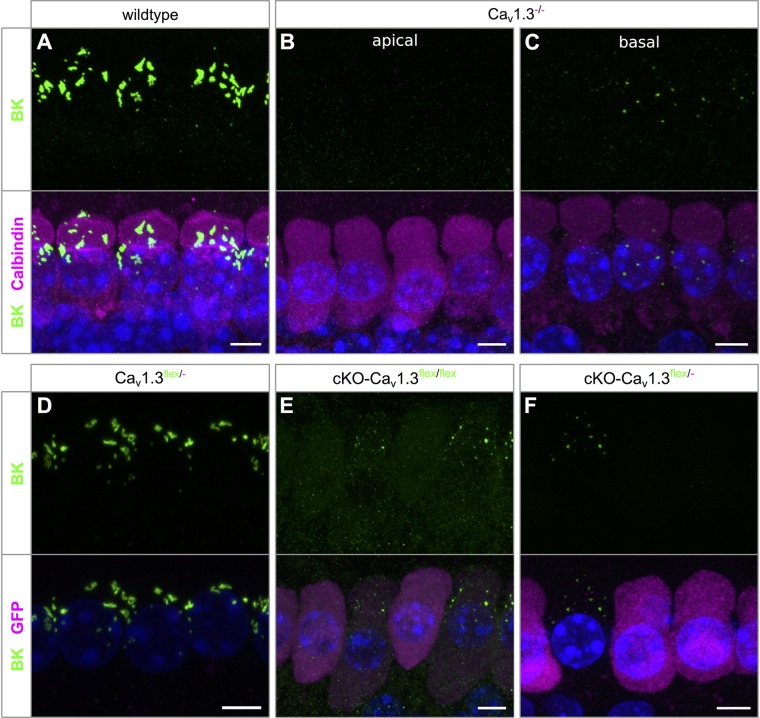
BK channel expression is related to reduced GFP labeling in cKO-Cav1.3flex/flex and cKO-Cav1.3flex/- IHCs. (A–C) MIP of confocal stacks of IHCs labeled for BK (green) and calbindin (magenta) of a wildtype (A) and a Cav1.3-/- mouse (B,C) at the age of 4–5 weeks. (A) Large spots of BK immunoreactivity at the neck of wildtype IHCs. (B,C) In Cav1.3-/- IHCs, BK immunolabeling was absent from apical-turn IHCs (B) and vastly reduced in IHCs of the basal turn (C) compared with apical-turn wildtype IHCs (A). (D–F) Co-labeling for BK channels (green) and GFP (magenta) in apical-turn IHCs of a control Cav1.3flex/-
(D), a cKO-Cav1.3flex/flex
(E) and a cKO-Cav1.3flex/- mouse (F). (D) Normal, wildtype-like BK labeling at the neck in control Cav1.3flex/- IHCs. (E,F) BK labeling was absent from those IHCs of the cKO-Cav1.3flex/flex mouse with strong GFP labeling (E) and from GFP-positive IHCs of the cKO-Cav1.3flex/- mouse (F). Note dot-like BK labeling in those IHCs of the cKO-Cav1.3flex/flex mouse with weak GFP expression (E) and in a GFP-negative IHC of the cKO-Cav1.3flex/- mouse (F), both indicative of a non-switched flex allele. Scale bar: 5 μm.